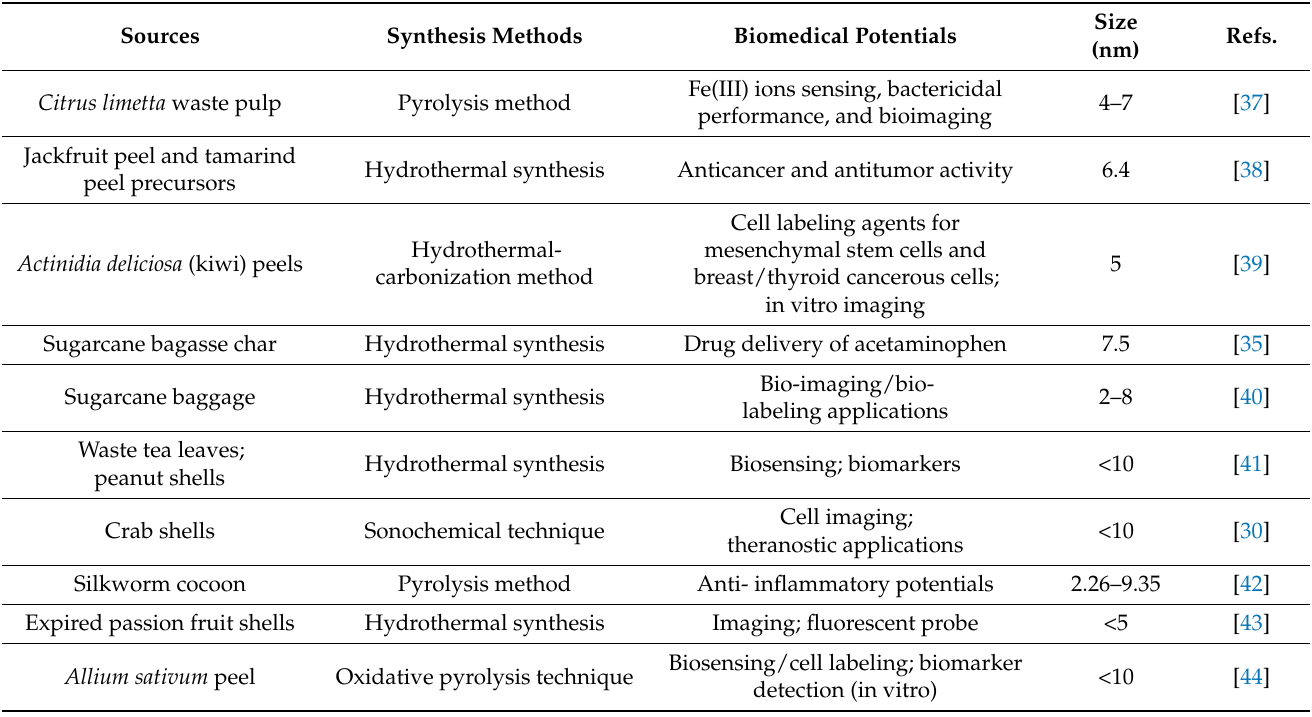
Table 1. Some selected examples of biowaste-derived CDs with their fascinating biomedical